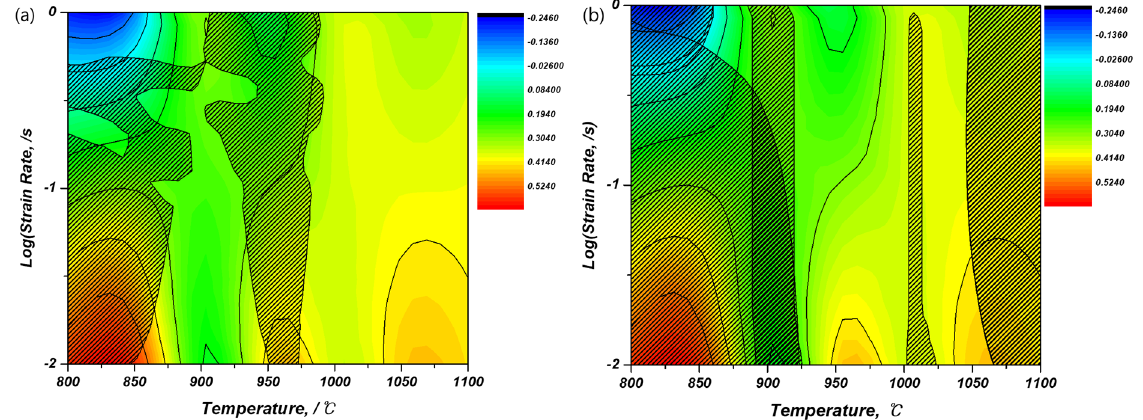
Figure 11. Complex processing map showing the stable and unstable deformation region ( ε = 0.6); ( a ) Ziegler’s instability criterion, ( b ) Malas’s instability criterion. Shaded area means the unstable region.